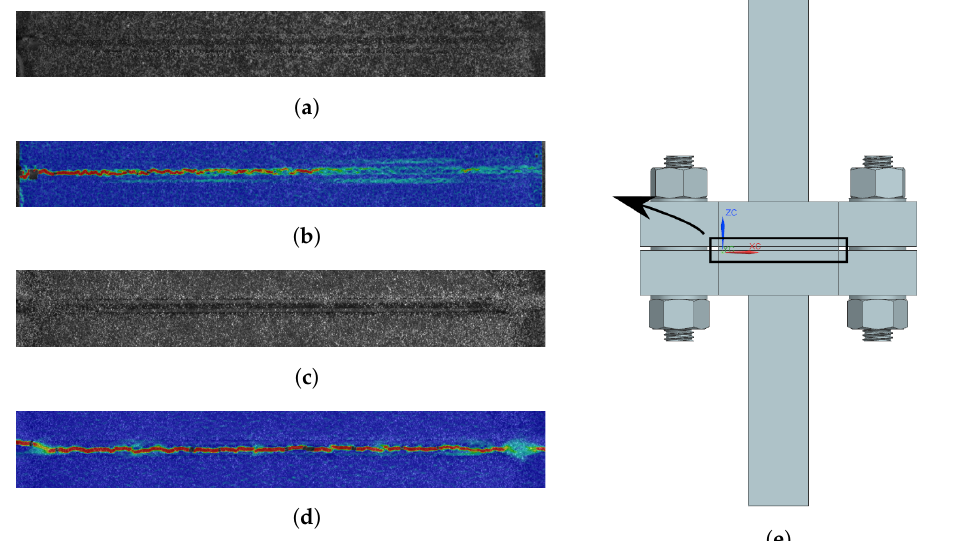
Figure 10. Two types of core fracture are compared in the figure: tearing and brittle fracture. ( a , c ) contain the speckle pattern, whereas ( e ) indicates, approximately, analyzed area. In ( b ), the strain field of the core is presented with strain localized near the left edge due to tearing. In ( d ), the strain is evenly distributed over the core, causing a brittle